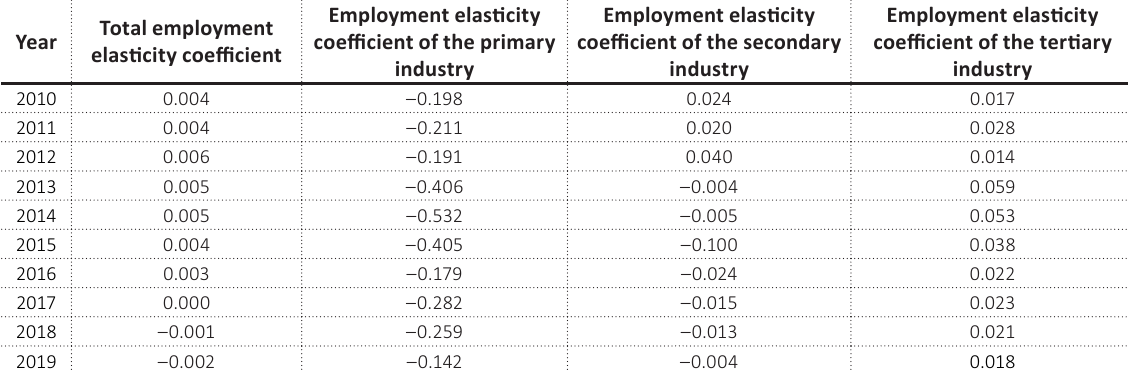
Table 1. Employment elasticity coefficient of various industries in China (2010–2019) Source: Calculated based on relevant data from the National Bureau of Statistics of China